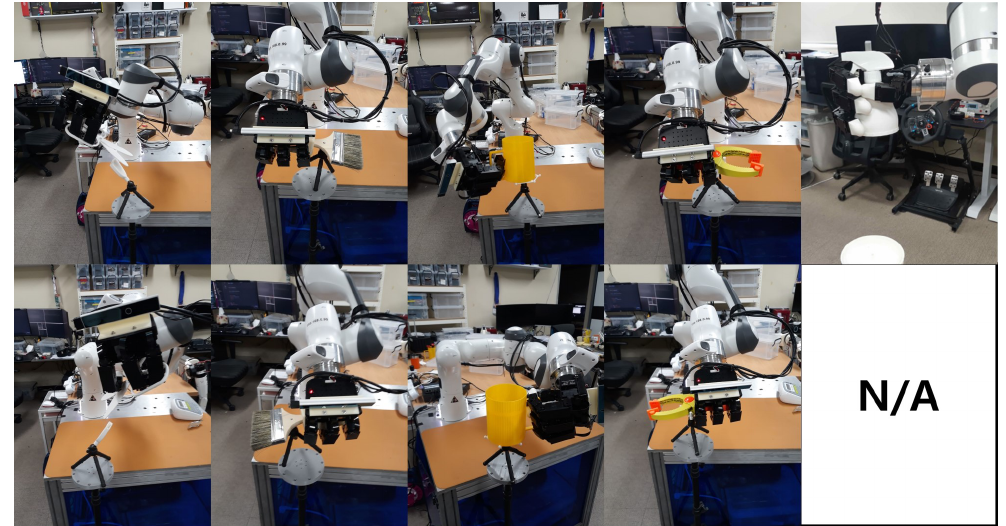
Figure 10. Different grasping strategies based on the object